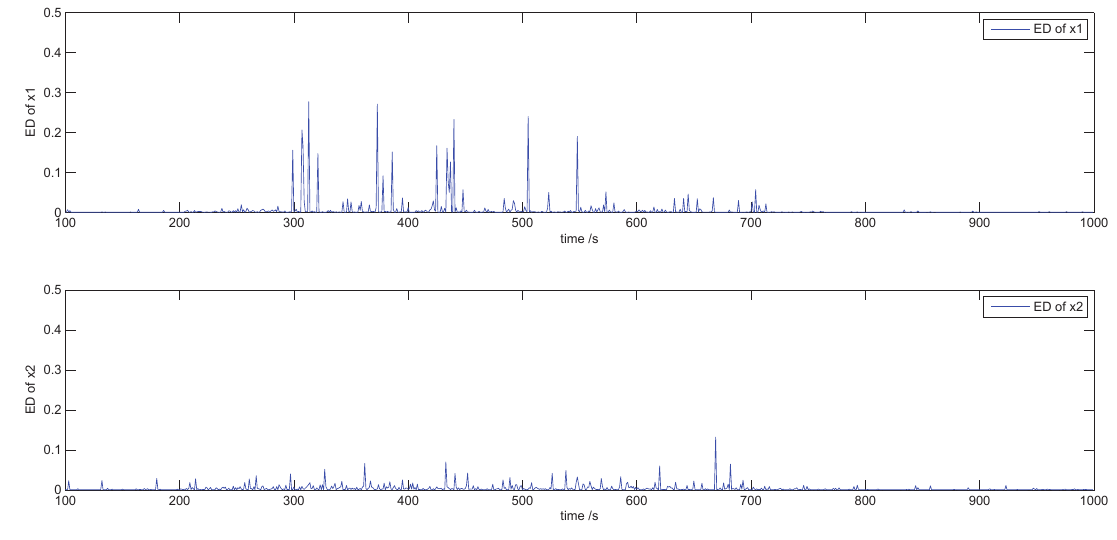
Figure 9. The error between measure and estimation.